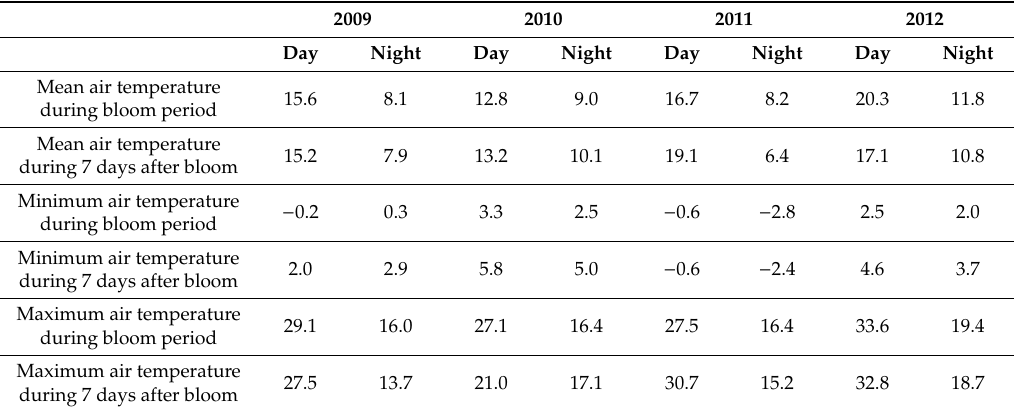
Table 2. Air temperatures in experimental plot at bloom time in